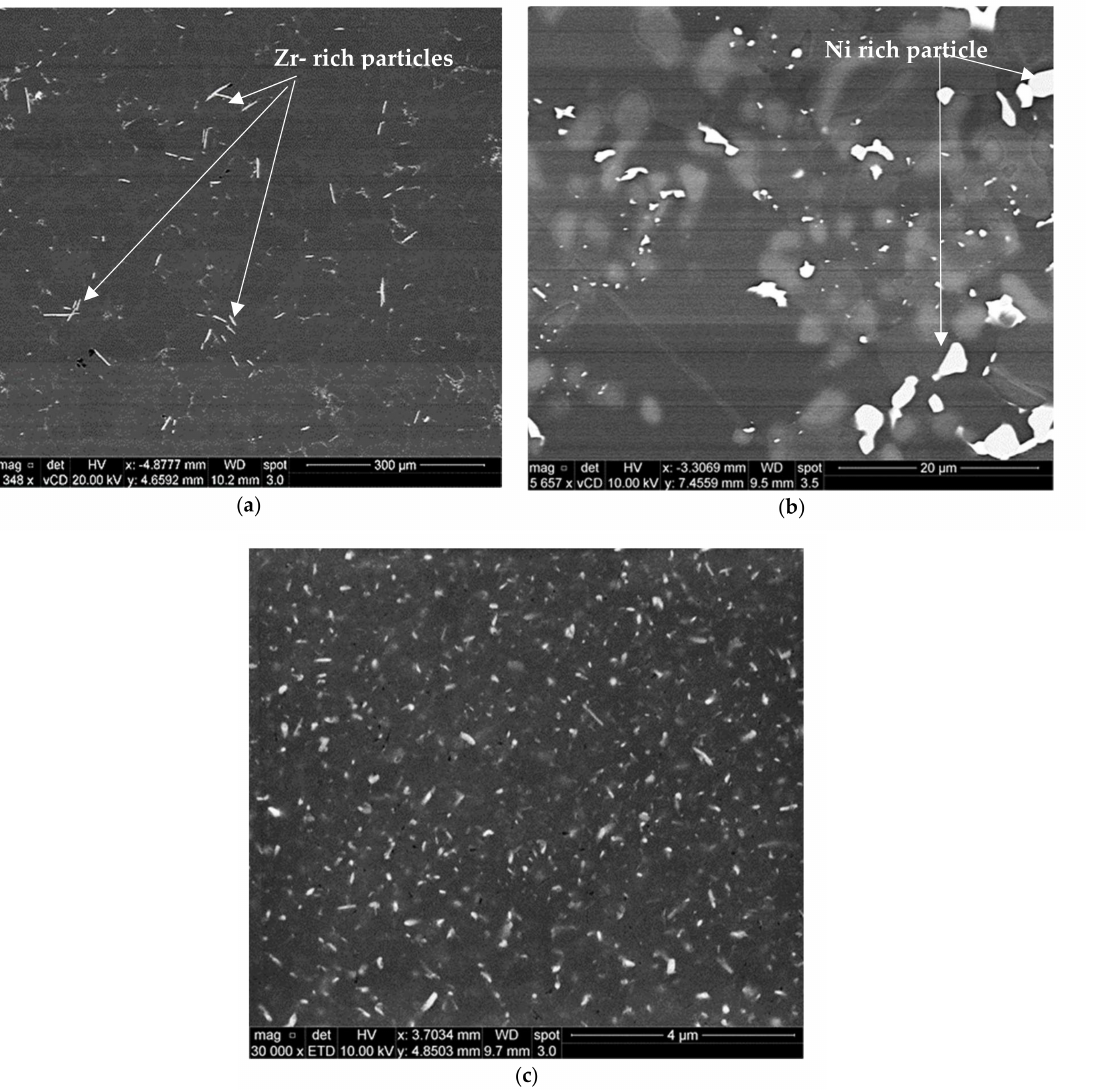
Figure 5. Backscattered electron images showing the size and distribution of precipitates in T6-treated alloys after stabilization at 250 ◦ C for 1 h: ( a ) M1S, ( b ) M2S, ( c ) M3S alloys (testing at 250 ◦ C)-mixture of Zr-, and Cu-rich phase